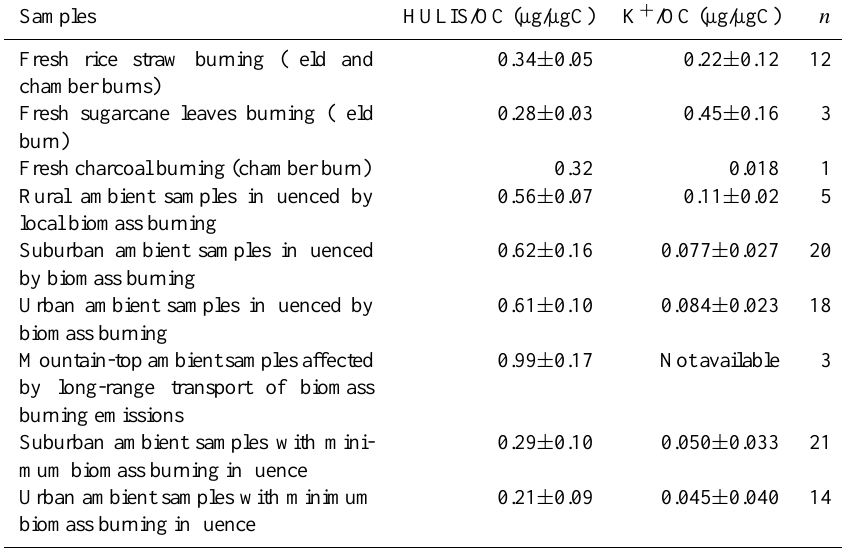
Table 1. HULIS/OC and K + /OC values in fresh biomass burning emissions and in different groups of ambient samples. Samples HULIS/OC (µg/µgC) K + /OC (µg/µgC) n Fresh rice straw burning (field and chamber burns) Fresh sugarcane leaves burning (field burn) Fresh charcoal burning (chamber burn) 0.32 Rural ambient samples influenced by local biomass burning by biomass